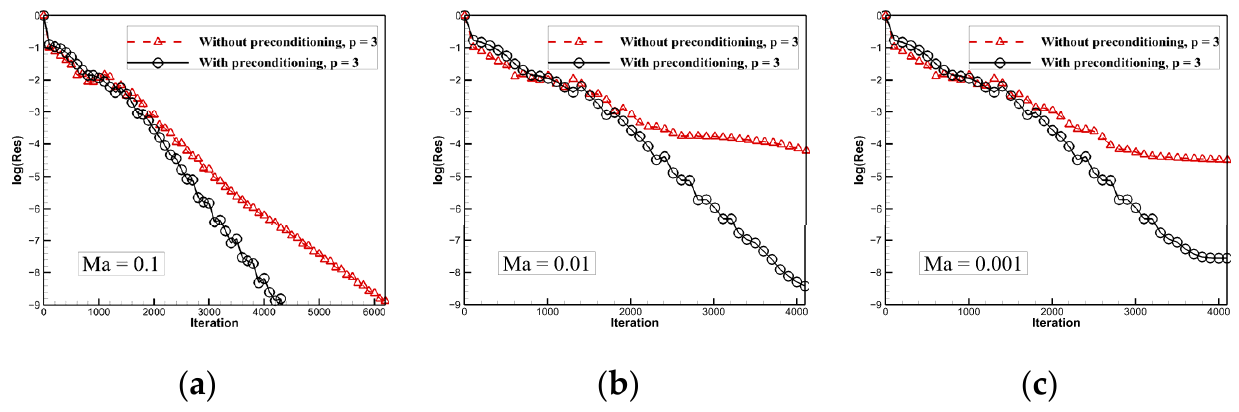
Figure 5. The convergence histories of flows over NACA0012 airfoil. ( a ) 𝑀𝑎 = 0.1 ; ( b ) 𝑀𝑎 = 0.01 ; and ( c ) 𝑀𝑎 = 0.001 .